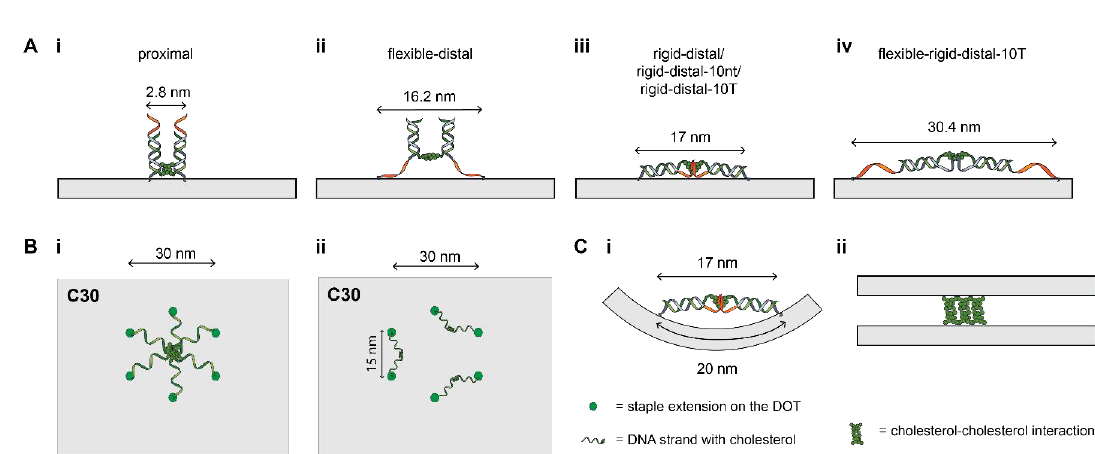
Figure 3. Schematic showing potential interactions between cholesterols (green) that could promote aggregation of the DOT (grey). ( A ). Schematic showing the maximum distance between cholesterols at which they could interact for the different spacer designs. This assumes the DOT is flat, if the DOT is curved or folded then the distances would be smaller ( C i); ( B ). Possible intra-DOT cholesterol interactions. ( i ) Interaction between all six cholesterols in the circular configuration. ( ii ) Interactions between adjacent cholesterols; ( C ). Possible intra-DOT and inter-DOT interactions. ( i ) The flexible DOT structure could bend to allow for cholesterols on its surface to interact even when the planar distance between the cholesterols on the surface of DOT exceeds the distance required for them to interact. ( ii ) Cholesterols on different DOTs can interact to form higher order structures.